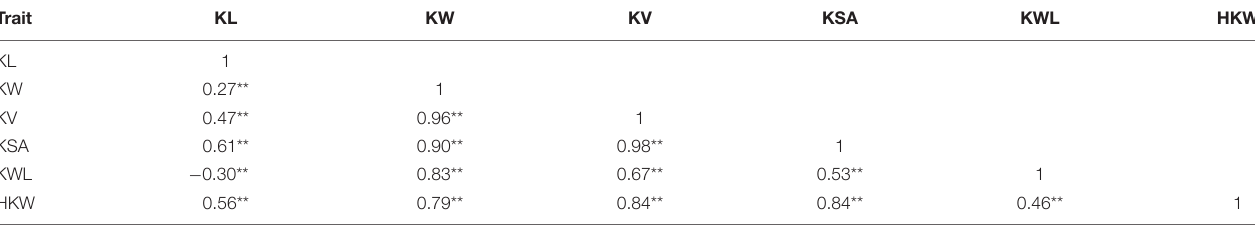
TABLE 3 | The correlation analysis of the six kernel traits based on best linear unbiased prediction (BLUP) values. Trait KL